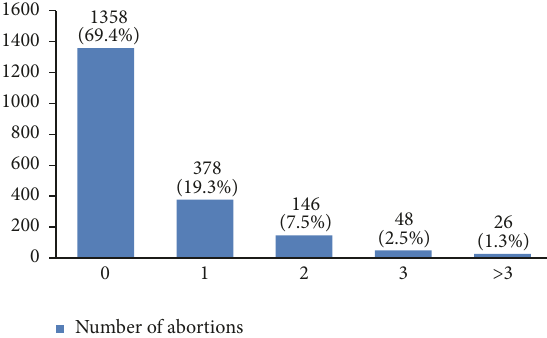
Figure 8: The number of abortions of the studied breast cancer cases.